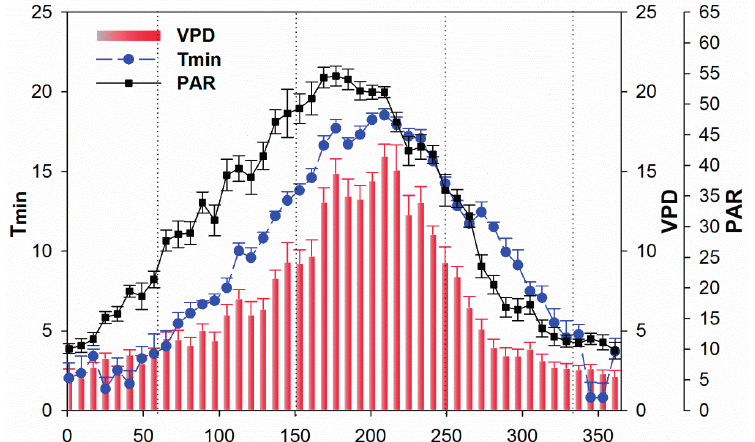
Figure 3. Meteorological data collected at the flux tower site from 2001–2010. Eight-day averages for vapor pressure deficit (VPD, in hPa), minimum temperature (T min , in °C) and photosynthetically active radiation (PAR, in mol·m − 2 ·day − 1 ). The dashed lines represent the seasons: spring (DOY 65–152), summer (DO 153–248), autumn (DOY 249–335) and winter (DOY 0–64 and